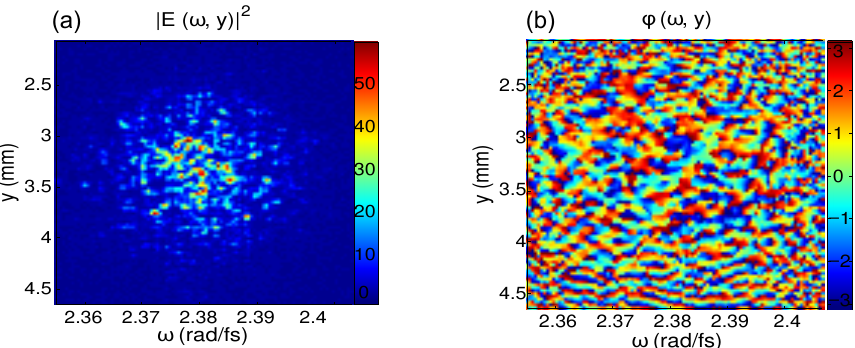
Fig. 1. Experimental reconstruction of the spatio-spectral electric field of the scattered-transmitted light from a thick scattering sample. (a) Spatio-spectral intensity I ( ω,y ) of the speckle. (b) Speckle spatio-spectral phase φ ( ω,y ).